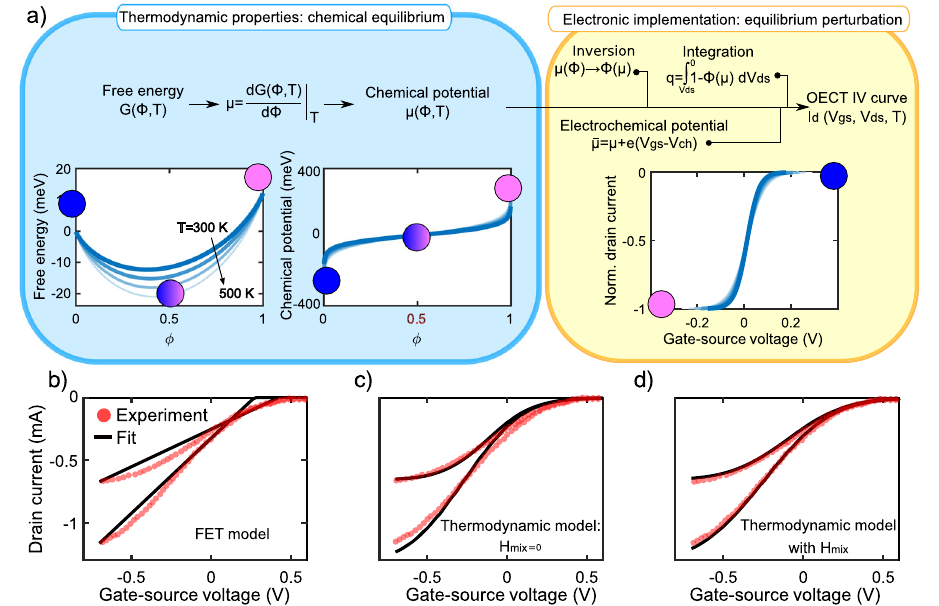
Fig. 3 | Thermodynamic model and fi ts. a Step-by-step work fl ow of our thermo- dynamicanalysis.StartingwiththeGibbsenergyG,thechemicalpotential μ canbe obtained.Thesepropertiesarematerial-speci fi candbymeasuringtheresistanceof the PEDOT/electrolyte system only the equilibrium can be probed. By applying an external fi eld, the equilibrium is perturbed (yellow box), and the current-voltage characteristicscanbeobtainedasexplainedinthemaintextandinSupplementary Note 2. The pink and blue spheres indicated a fully oxidized and fully reduced PEDOT phase, respectively. b Transfer characteristics of a PEDOT:PSS OECT with a